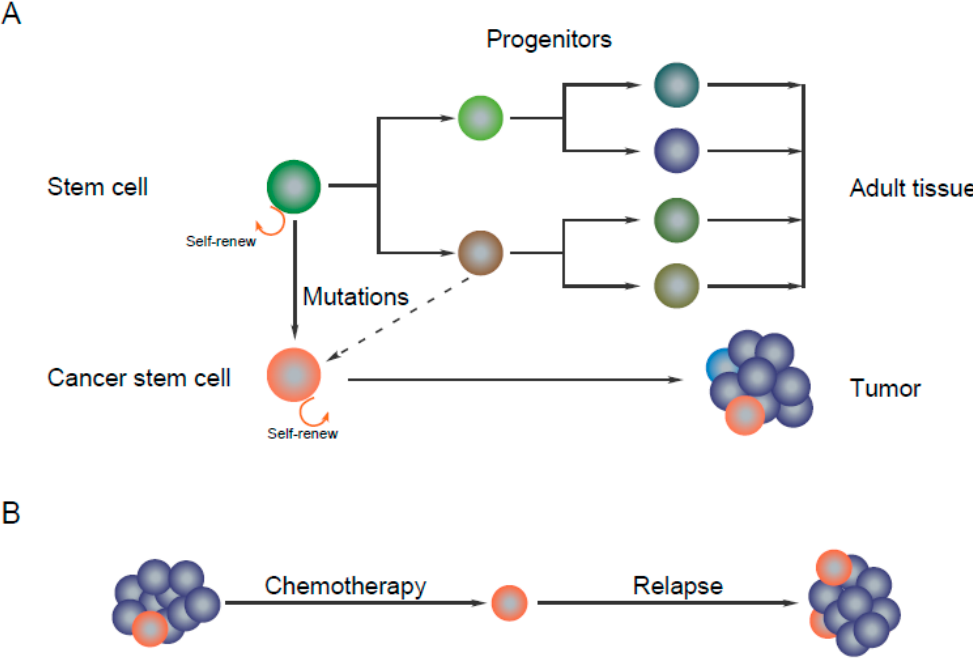
Figure 1. Cancer stem cells: ( A ) To form normal tissue, mature cells develop from the stem cell that differentiates to generate progenitors. Cancer stem cells develop from the normal stem cells or progenitors due to multiple mutations in oncogenes or tumor suppressors. Like normal stem cells, cancer stem cells also have self-renewal capacity. ( B ) Due to distinct drug-resistance properties, cancer stem cells can survive chemotherapy-induced cell death and thereby form new tumors.